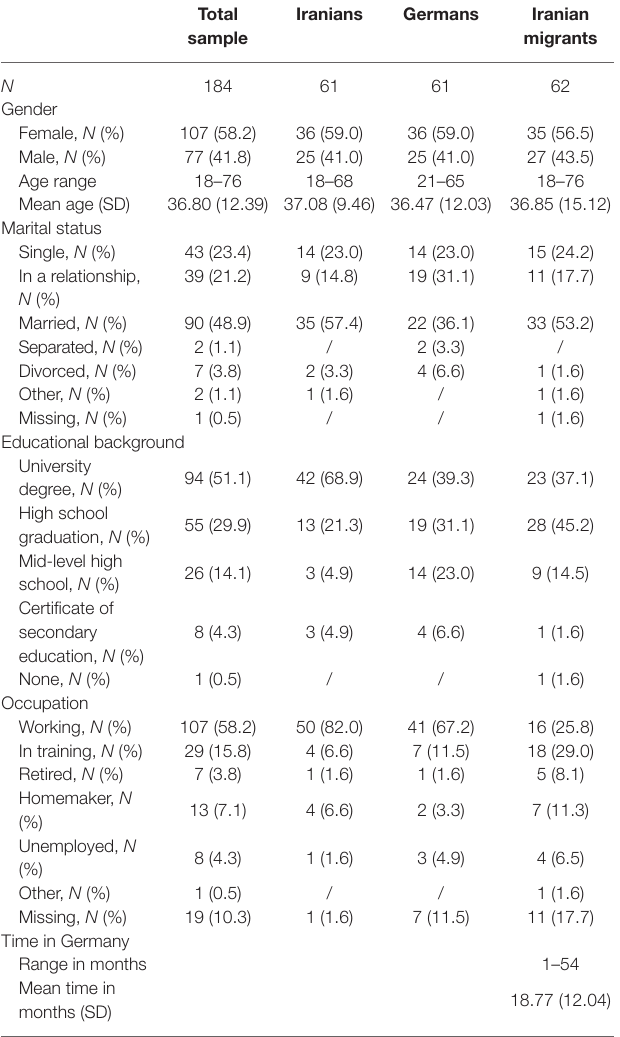
TABLE 2 | Intercorrelations between anger-reaction (AR), anger-control (AC), anger-in (AI), and anger-out (AO) in the total sample ( N = 182).